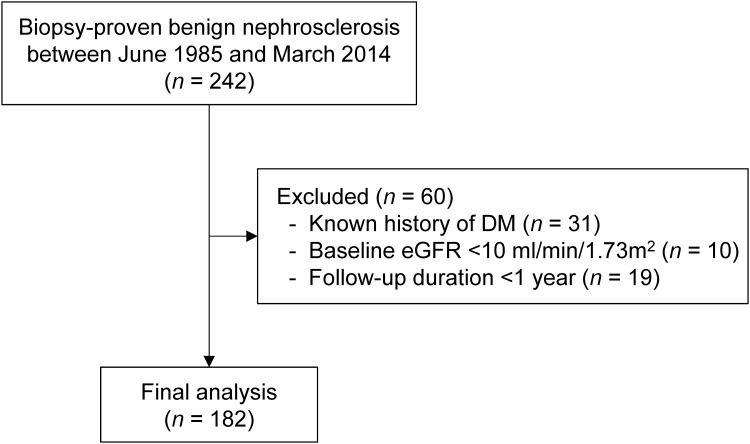
Flow chart of the study population.Abbreviations: DM, diabetes mellitus; eGFR, estimated glomerular filtration rate.